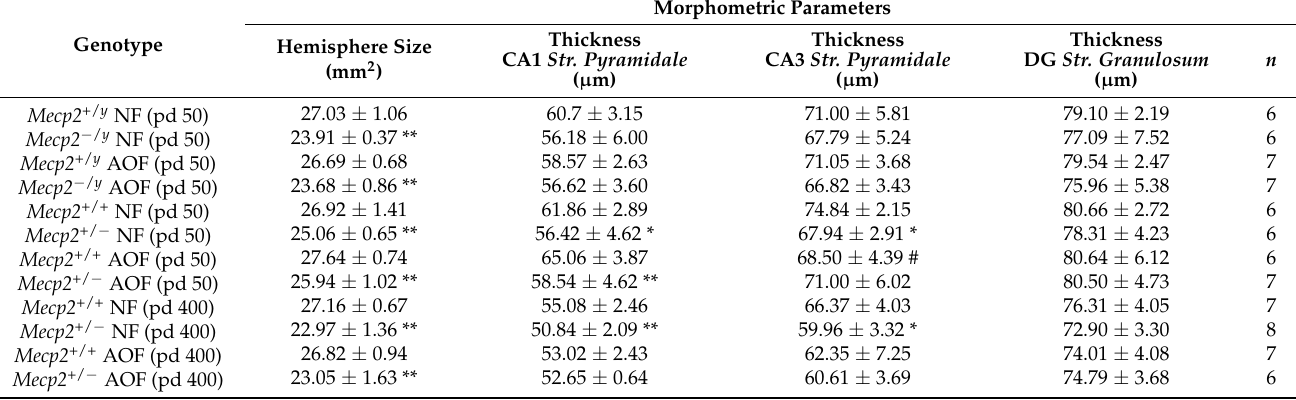
Table 2. Brain morphometric parameters distinguishing WT and Mecp2 -mutant mice and their modulation via AO treatment. Analyses were performed on PFA-fixed brains. Cell and layer structures were visualized with Nissl staining. Listed data are means ± SDs; n reports the number of mice Scheme 0. * p < 0.05, ** p < 0.01), and AO-treatment-mediated changes are marked by crosshatches (# p <